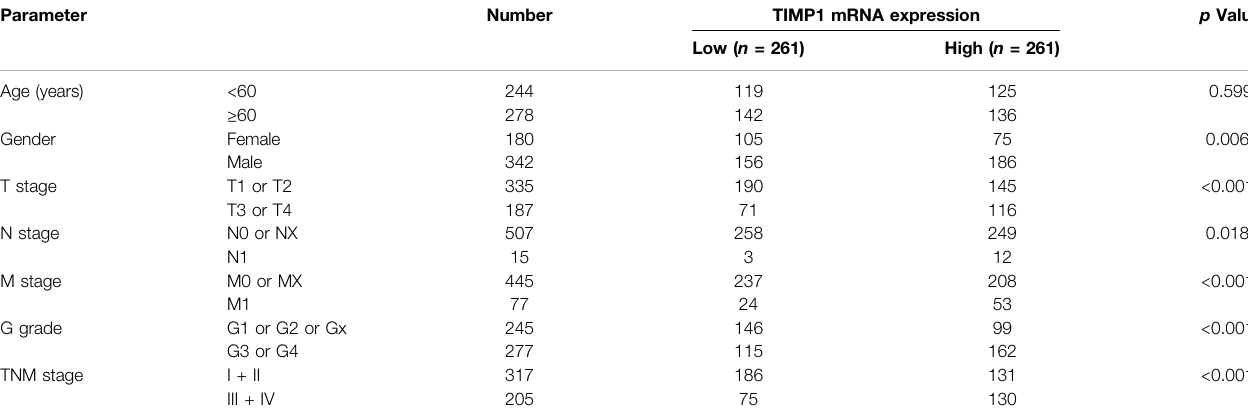
TABLE 4 | Correlation between TIMP1 mRNA expression and clinicopathological parameters of ccRCC patients. Parameter